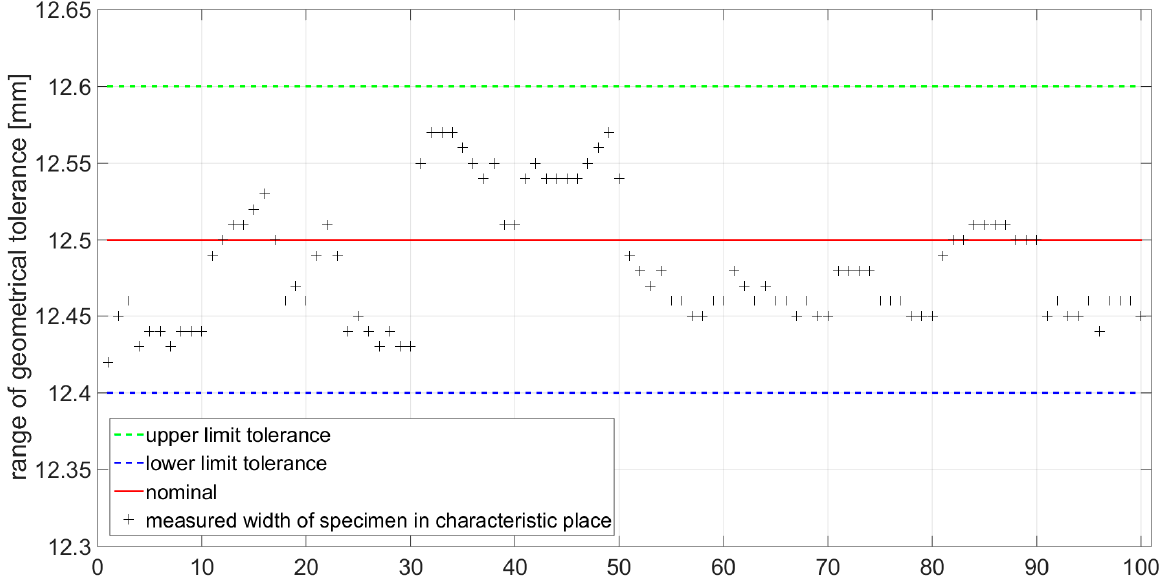
Figure 13. Measured values for specimens with 90° orientation of the material fibers. Statistically processed and evaluated data are given in Table 3.